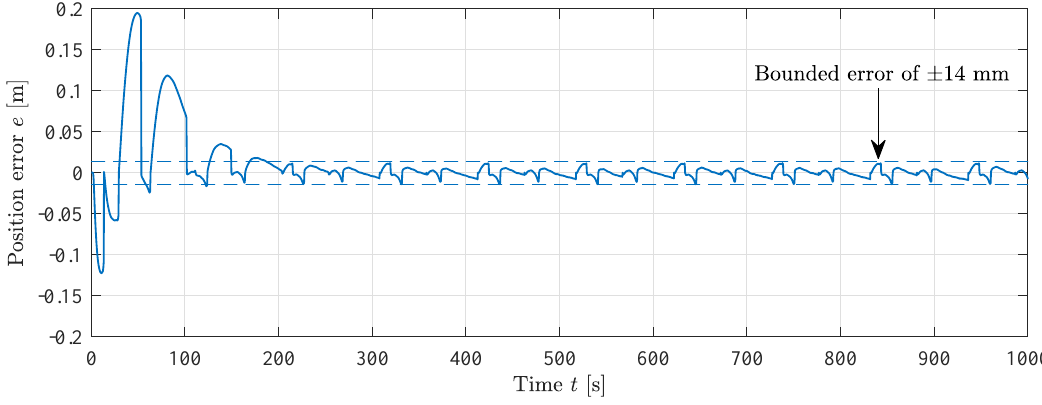
Figure 23. Position error during MIT-rule feedforward experiment, γ = 200 s · m − 3 .